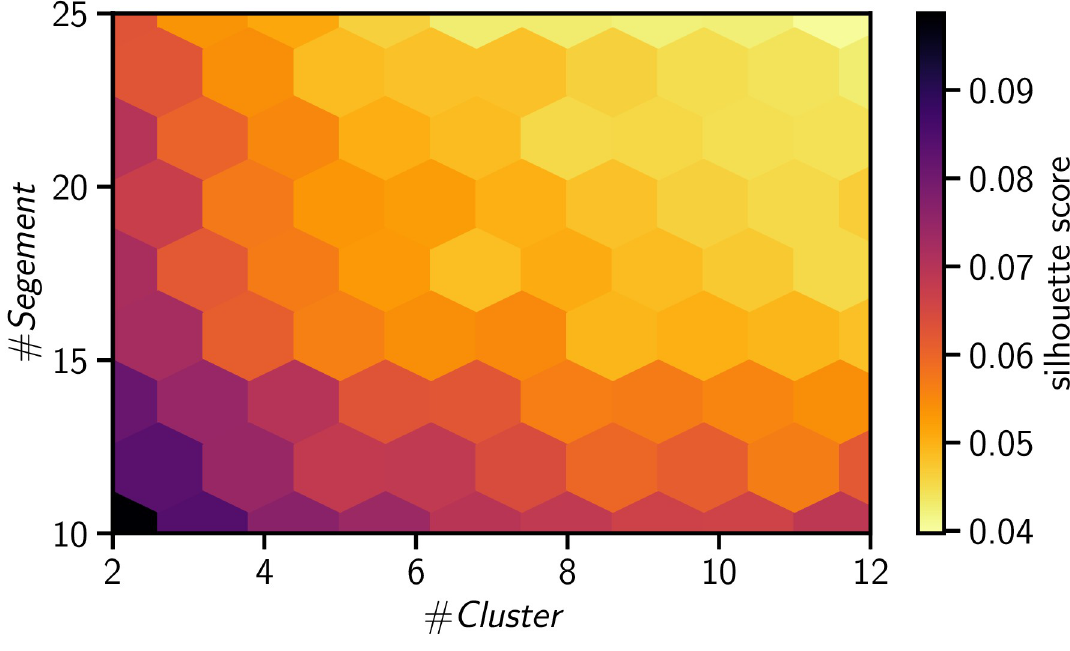
Fig 13. Silhouette